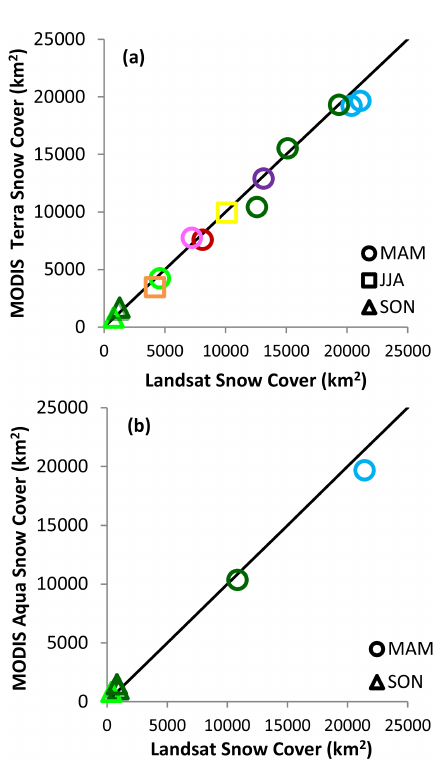
crease the threshold, the snow miss rate drops